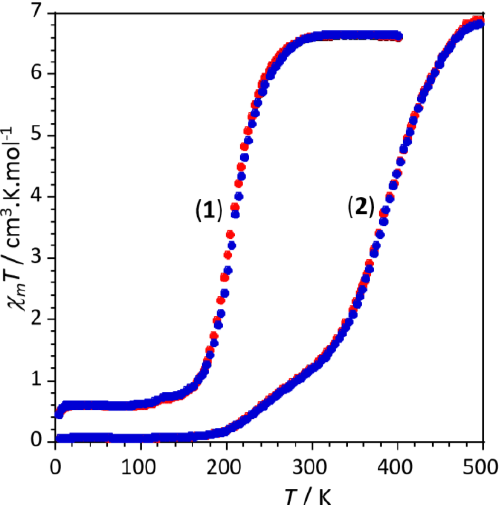
Figure 2. Thermal variation of the χ m T product for complexes 1 and 2 in the cooling (blue dots) and warming (red dots) scans.